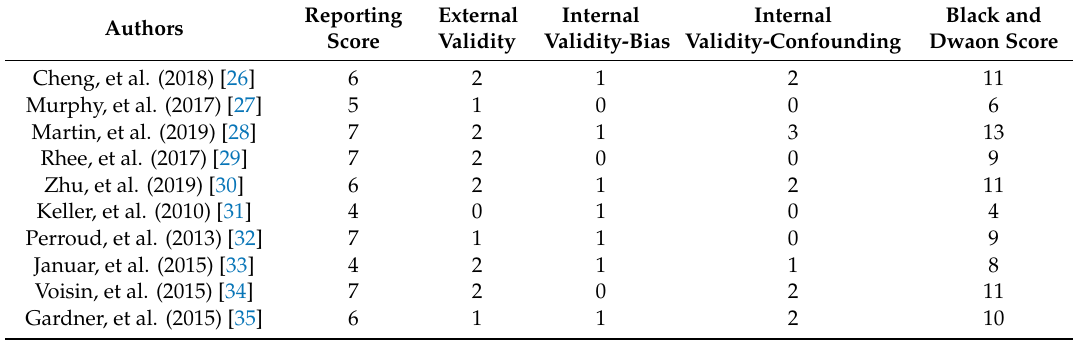
Table 4. Report of Black and down score.